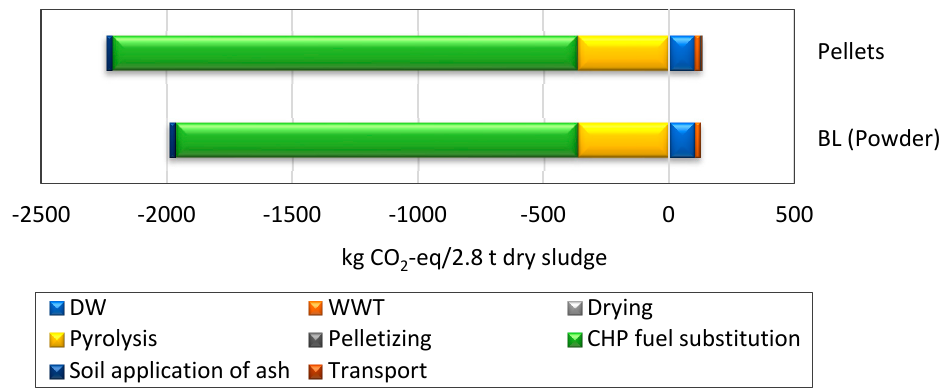
Figure 6. Sensitivity of the climate impact of Pyrochar Scenario to changing the pyrochar form from powder to pellets.